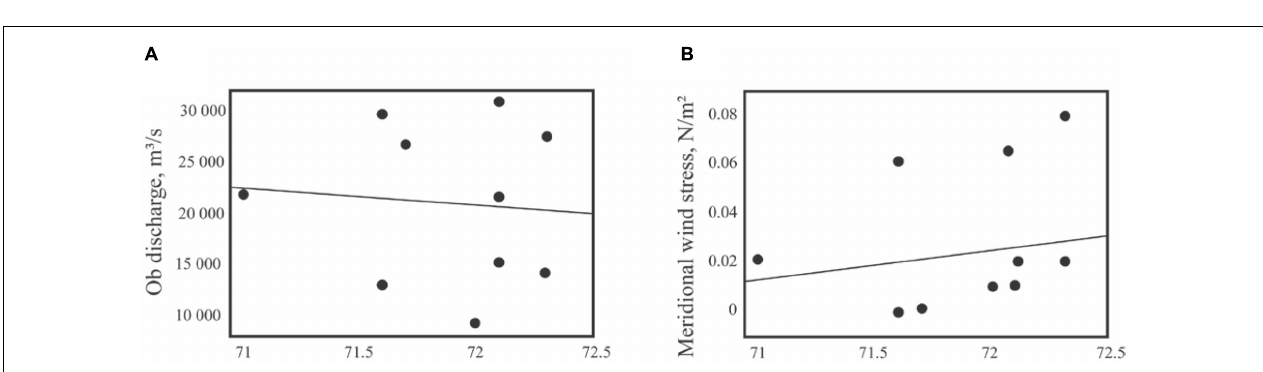
FIGURE 6 | Relations between the discharge rates of the Ob River (A) and the along-estuarine wind stress (B) with registered distances of saline inflows to the Gulf of Ob during the considered field surveys. Black lines represent the linear trends.